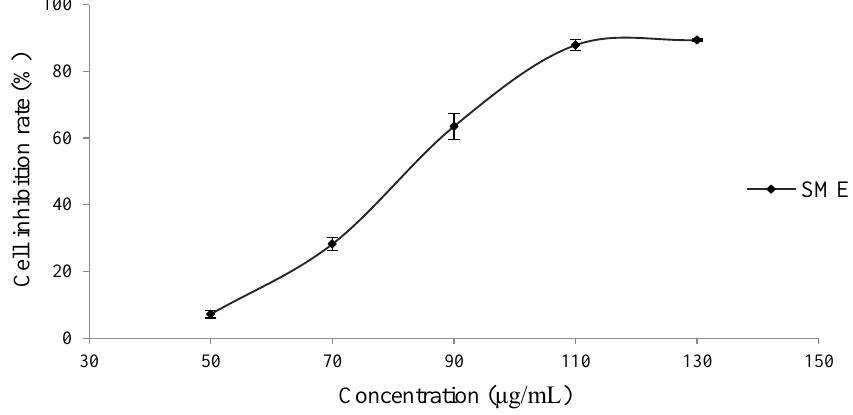
Figure 1. Inhibitory effect of the SME on H8 cells.